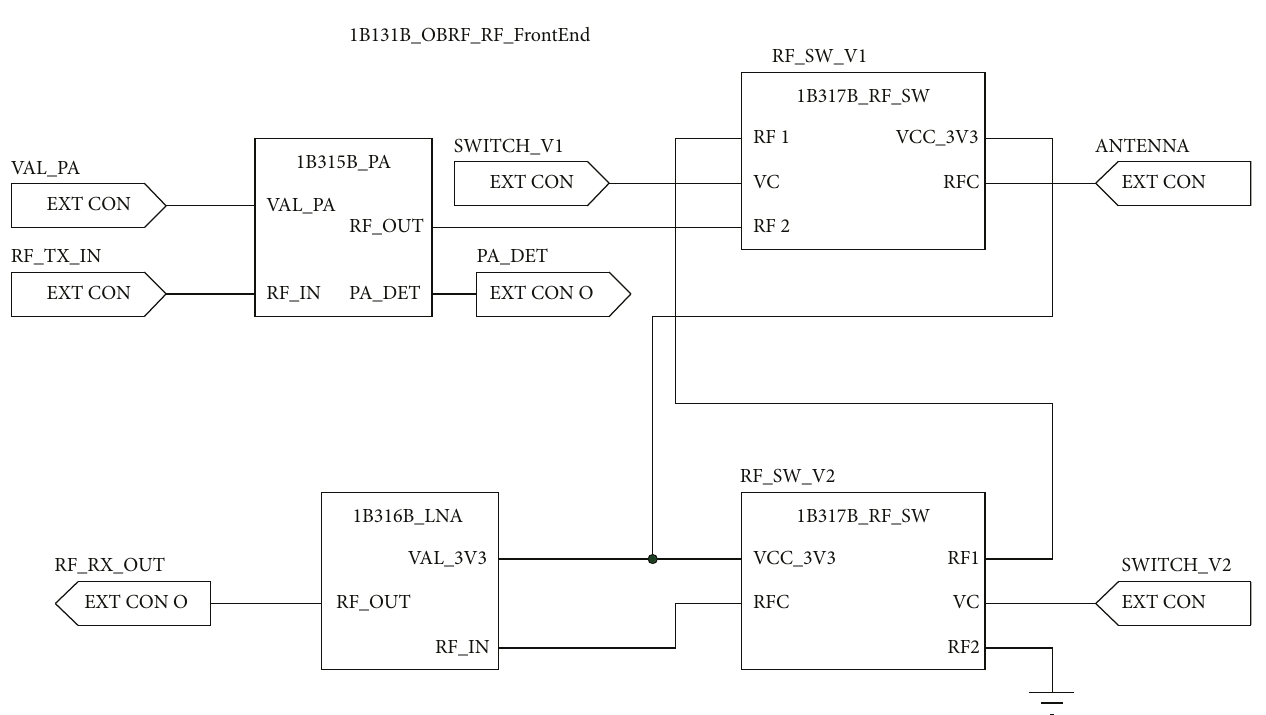
Figure 3: Mentor schematic of 1B31B_OBRF_RF_front